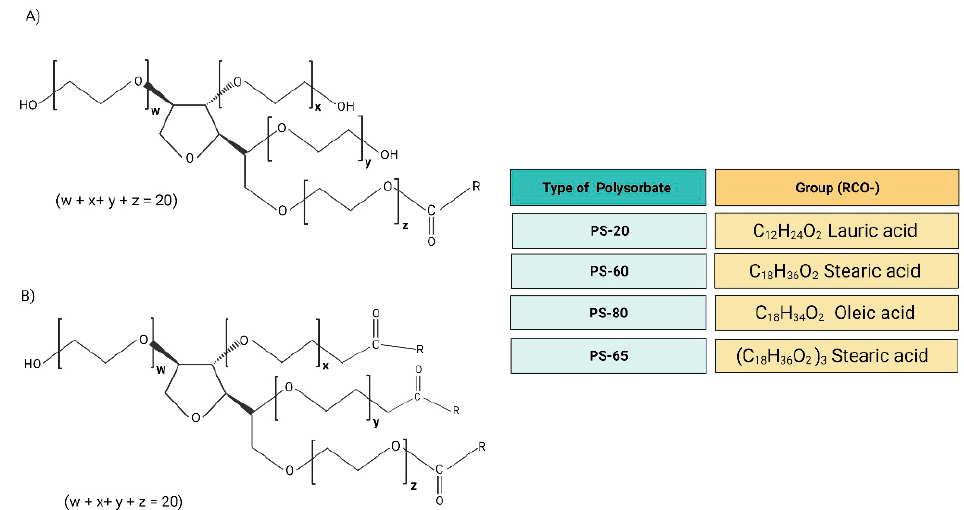
Figure 2. ( A ) Chemical structure of PS-20, PS-60, and PS-80. ( B ) Chemical structure of PS-65. PS-65 presents RCO-groups in x, y, and z, making it a tristearate molecule. The average of the total number of oxyethylene subunits on each polysorbate molecule (w + x + y + z) is 20. 3.3.